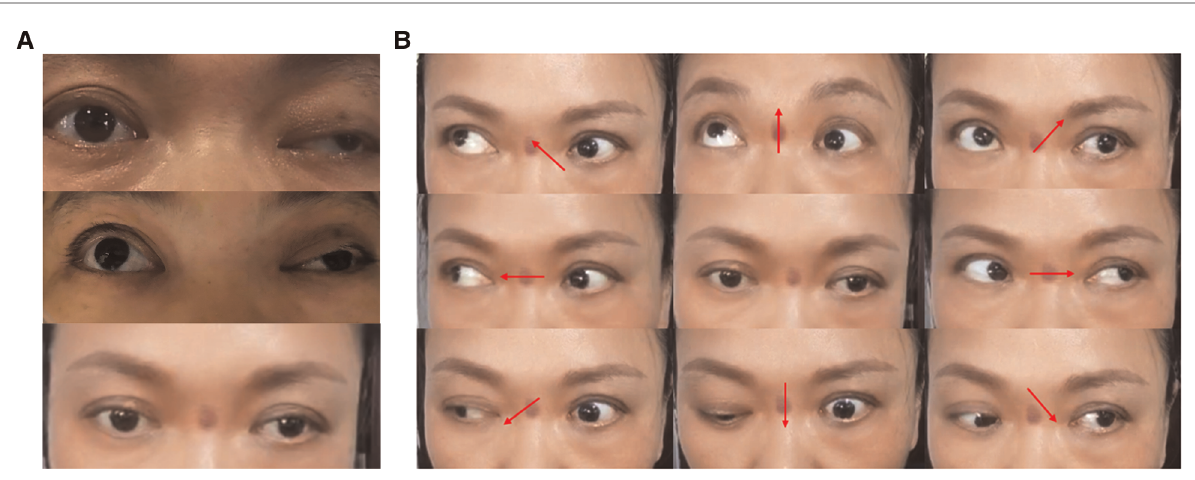
FIGURE 8 Changes in ptosis symptoms and eyeball movement 1 month after surgery. ( A ) Change in preoperative and postoperative ptosis symptoms: before surgery, 1 h after surgery and 1 month after surgery from top to bottom. ( B ) Changes in eyeball movement 1 month after surgery. Upward and downward movement disorder of the left eyeball